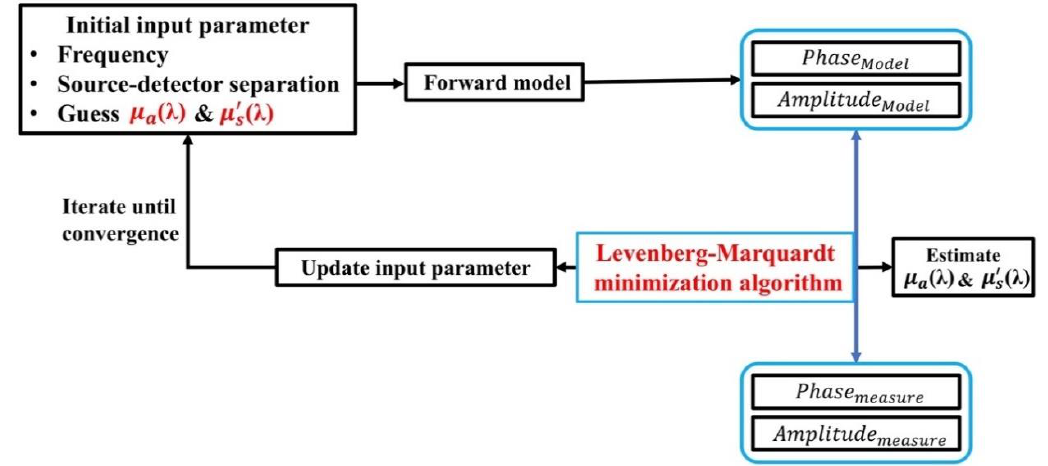
Figure 2. Flowchart of the measurement of optical properties.